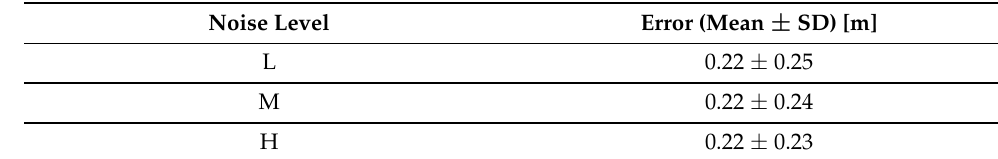
Table 3. Results of leakage position estimation of three separated waterdrops ( N = 26).